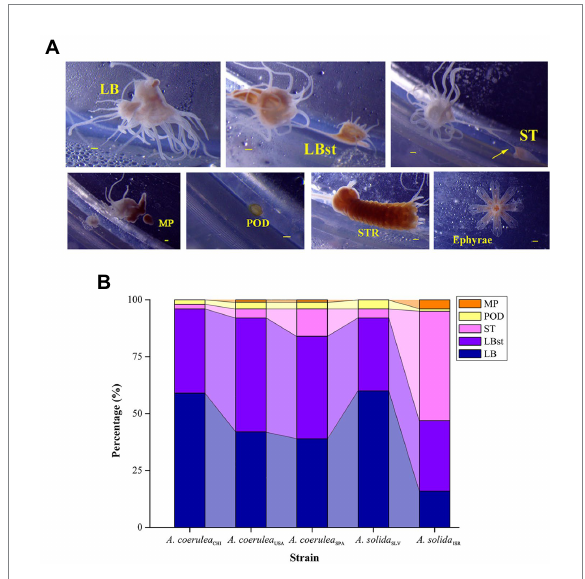
FIGURE 2 (A) Different asexual reproduction modes within Aurelia . LB: typical lateral budding; LBst: lateral budding by means of stolons; ST: reproduction from parts of stolons; MP: motile bud-like tissue particles; POD: podocysts; STR: strobilation. Scale bars = 100 μ m. (B) Proportions of each reproduction mode within the total reproduction. LB: typical lateral budding; LBst: lateral budding by means of stolons; ST: reproduction from parts of stolons; MP: motile bud-like tissue particles; POD: podocysts.